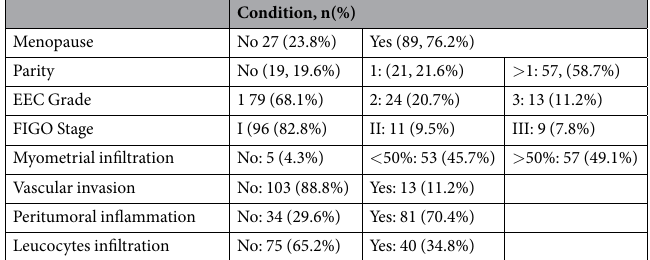
Table 1. Patient and Tumor Characteristics (n: